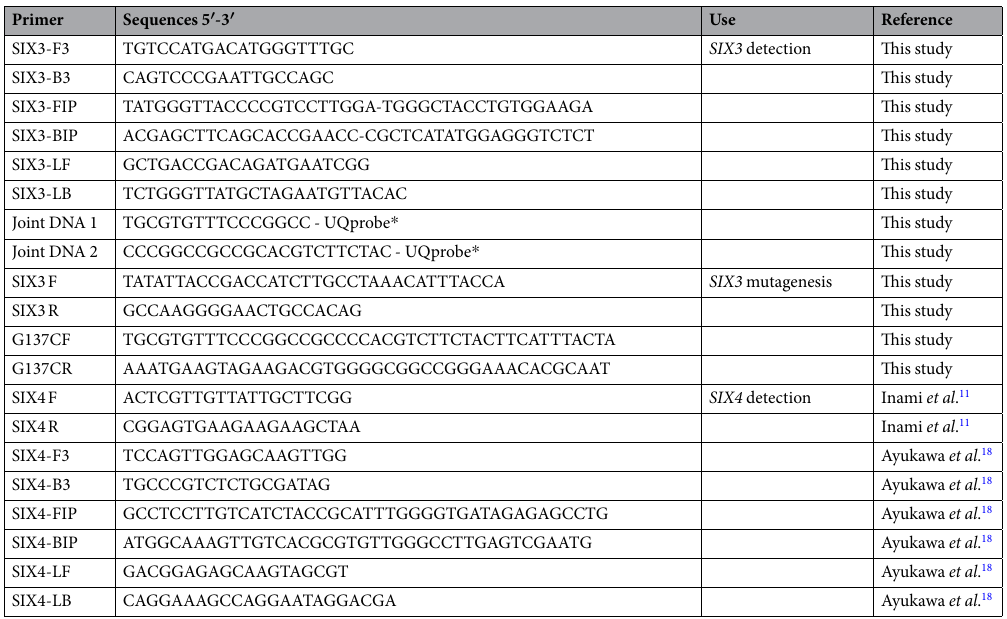
Table 2. Primers and joint DNAs used in this study. * 3 ′ ends of joint DNAs consist of UQprobe-G complementary